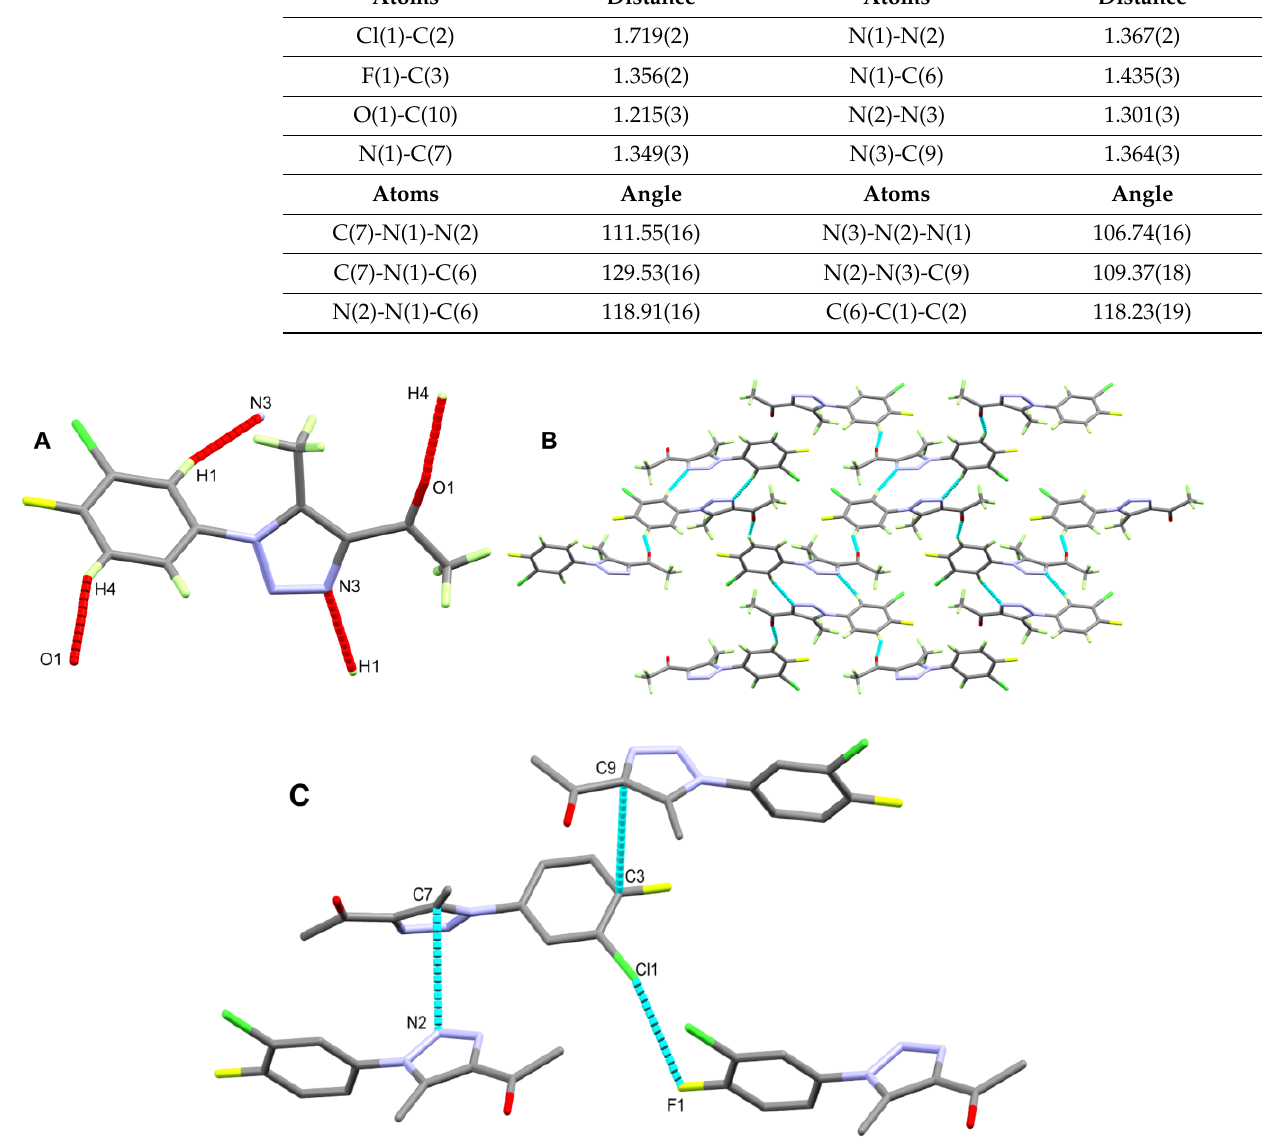
Figure 3. Possible contacts ( A ) and molecular packing view via C–H . . . N and C–H . . . O ( B ) and interhalogen/ π – π interactions ( C ) of triazole ligand 3 . Table 3. Hydrogen bonds for triazole ligand 3 and its Pd(II) complex 4 [Å and °].